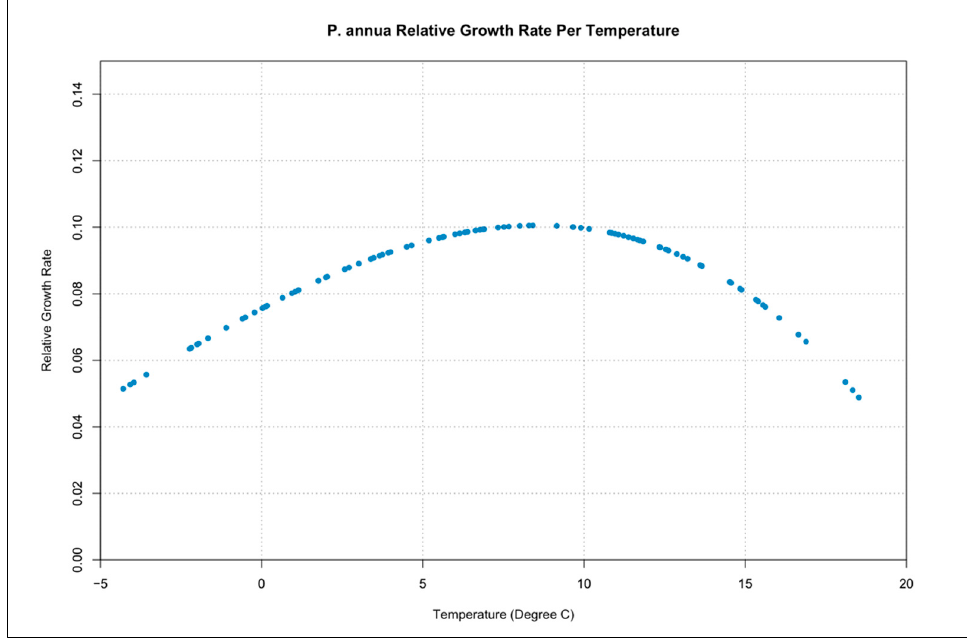
Figure 12. P. annua Relative Growth Rate Per Temperature.